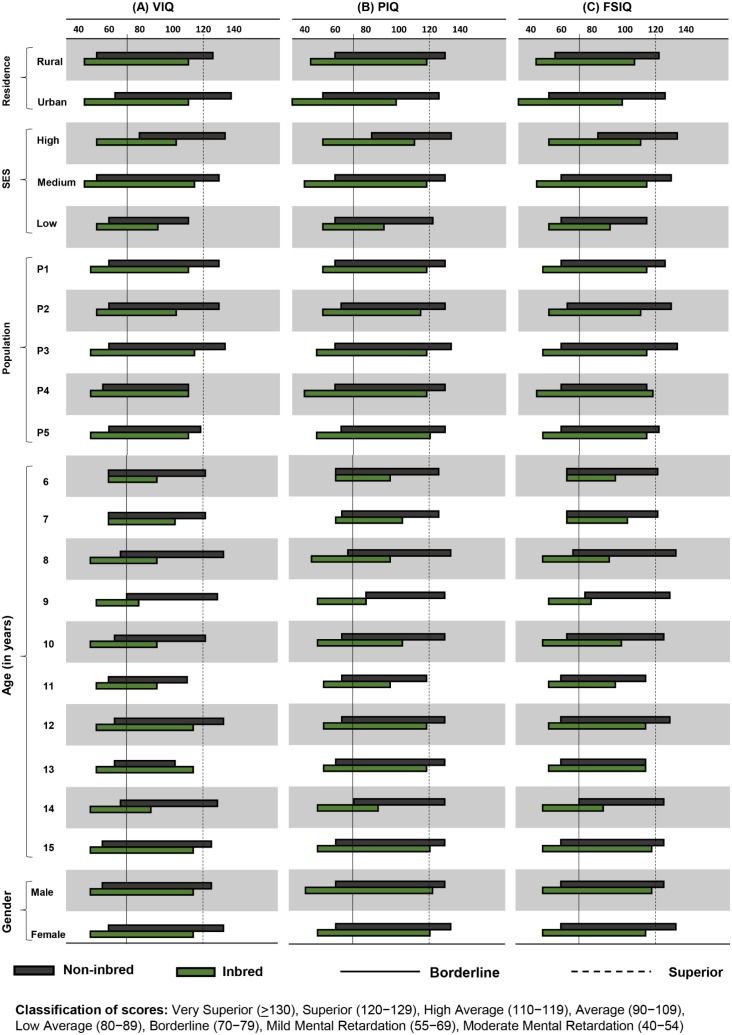
Range distribution of cognitive abilities for different factors.The IQ range has been established with minimum and maximum values observed for each category. Among all factors, inbred subjects exhibit a range shift toward low IQ, not crossing the superior IQ which is the indication of inbreeding load on the child’s cognitive abilities to have elevated levels of mental illness. Factors, like residence, SES and population (except age and sex) show significant differences though overall effect yet remained incompetent in comparison with inbreeding. The populations presented as, P1 = Gujjar and Bakarwal, P2 = Mughal, P3 = Malik, P4 = Syed, P5 = Khan.